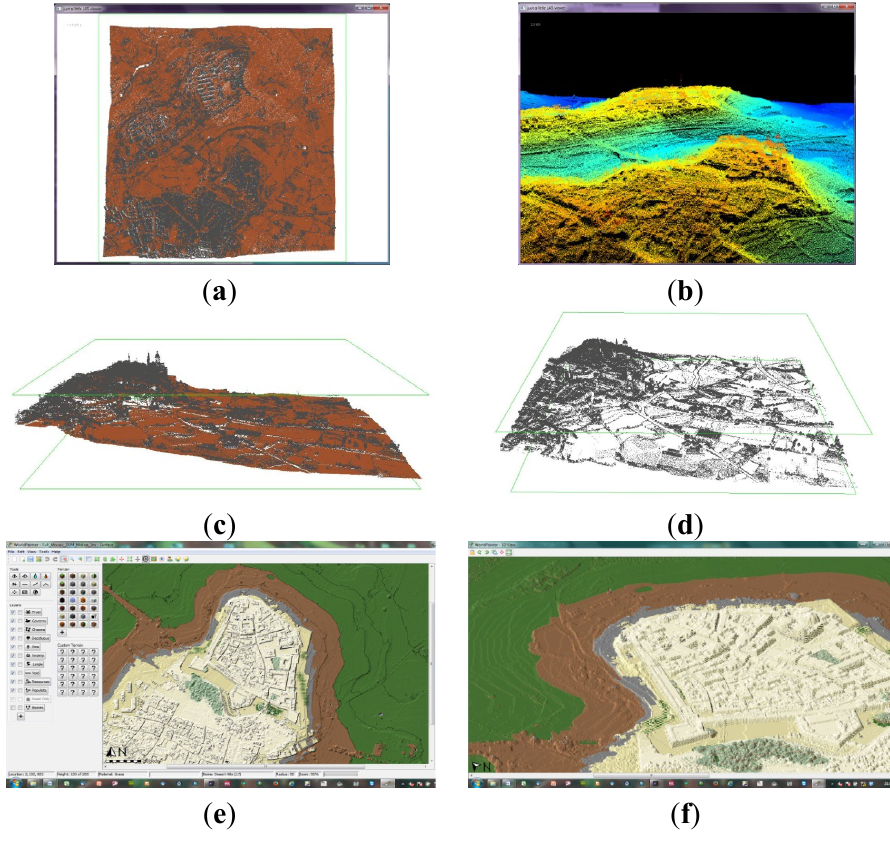
Figure 2. Initial Conversion steps ( a ) Mdina sheets integration in LasTools; ( b ) height map testing identifying comparative perspective for eventual immersive testing; ( c ) Mdina side perspective; ( d ) infrastructural outputs for post-conversion comparison; ( e ) Mdina conversion to Worldpainter; ( f ) Mdina Worldpainter 3D